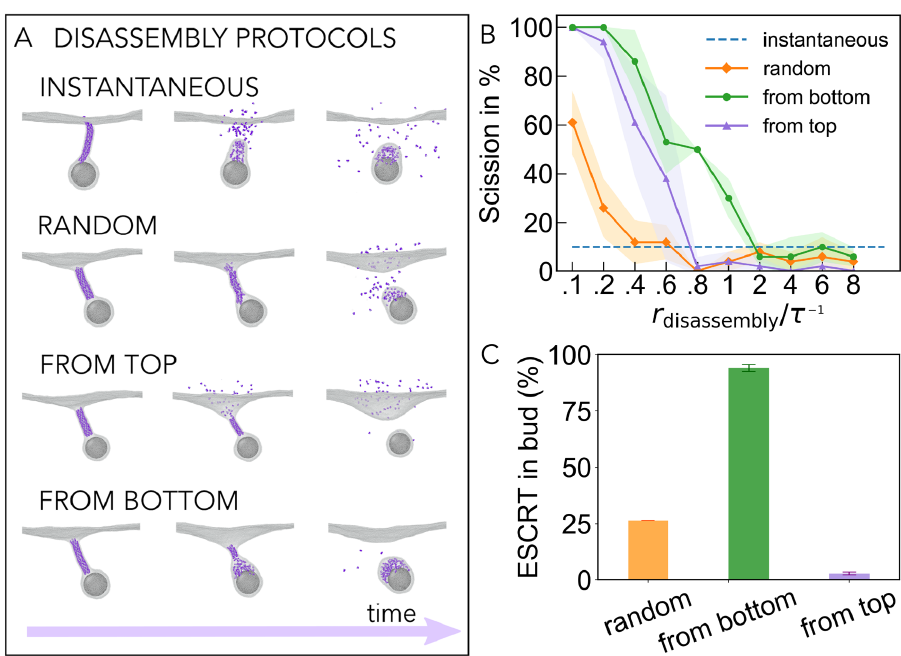
Fig 4. The role of final helix disassembly in neck scission. A: Four different protocols for the Tight Helix disassembly are explored, as shown with the representative snapshots along trajectories: instantaneous, randomised, sequential from the top, and sequential from the bottom. B: Membrane scission efficiency as a function of rate of filament disassembly for the different disassembly protocols ( R final = 5.7 nm). All the data is collected for r constriction = 2.1 × 10 − 3 nm/ τ , averaged over 5 independent measurements, and the standard deviation is indicated by the shaded area. C: Fraction of filament monomers located in the budded vesicle after successful scission.